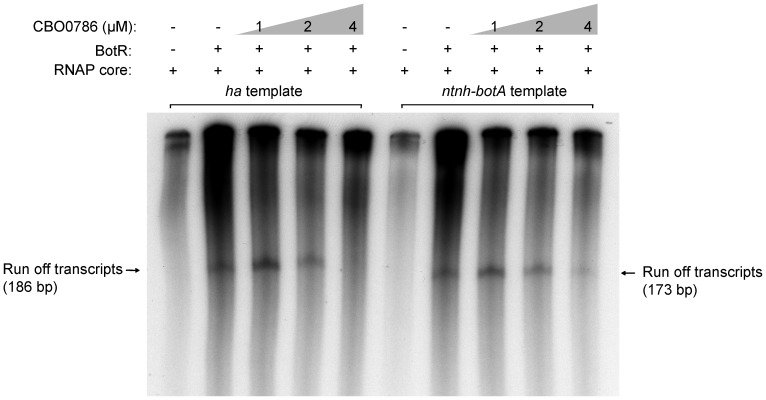
CBO0786 represses transcription from ha and ntnh-botA promoters in vitro.Run-off transcription from ha33 and ntnh-botA promoter-containing templates was repressed in the presence of increasing concentration of CBO0786. Arrow indicates the run-off transcripts.